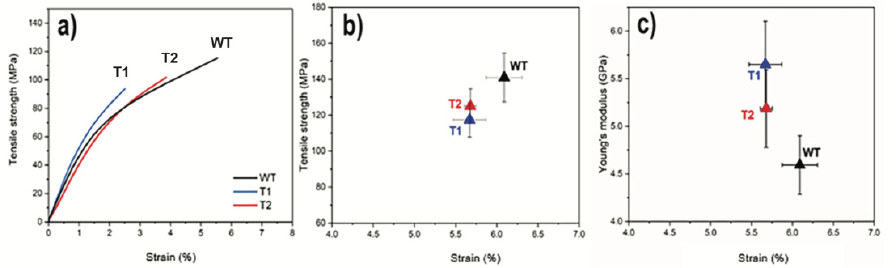
Figure 4. a ) Representative stress–strain curves of T1, T2, and WT; b ) Relation between tensile strength and strain; c ) Modulus and strain. (Error bars represent ± SD, n = 7).